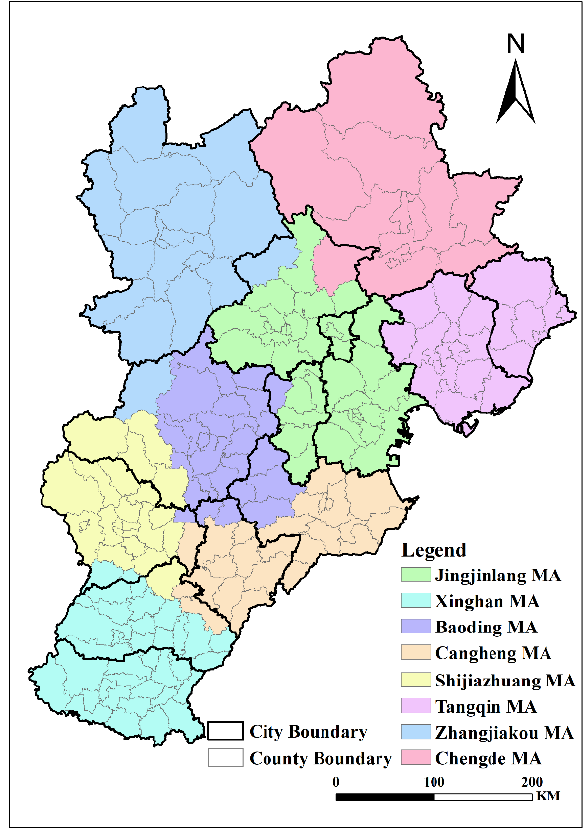
Figure 8. Metropolitan area identification results for the BTH region.